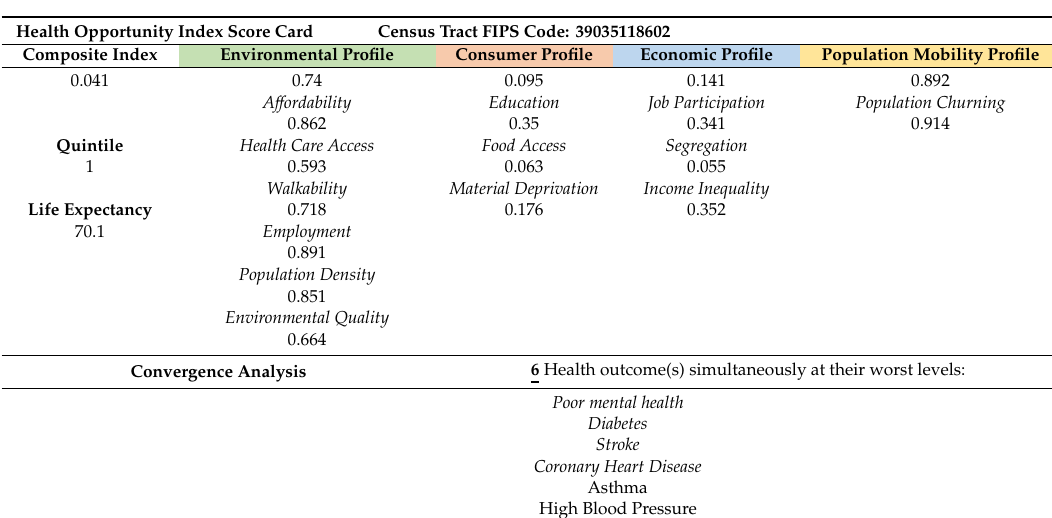
Table 2. Health Opportunity Index score card. See text for details. The score card displays the composite, profile and index score from the HOI the scores range from 0 to 1. The closer the number is to 0, the more responsible the score is for driving low health